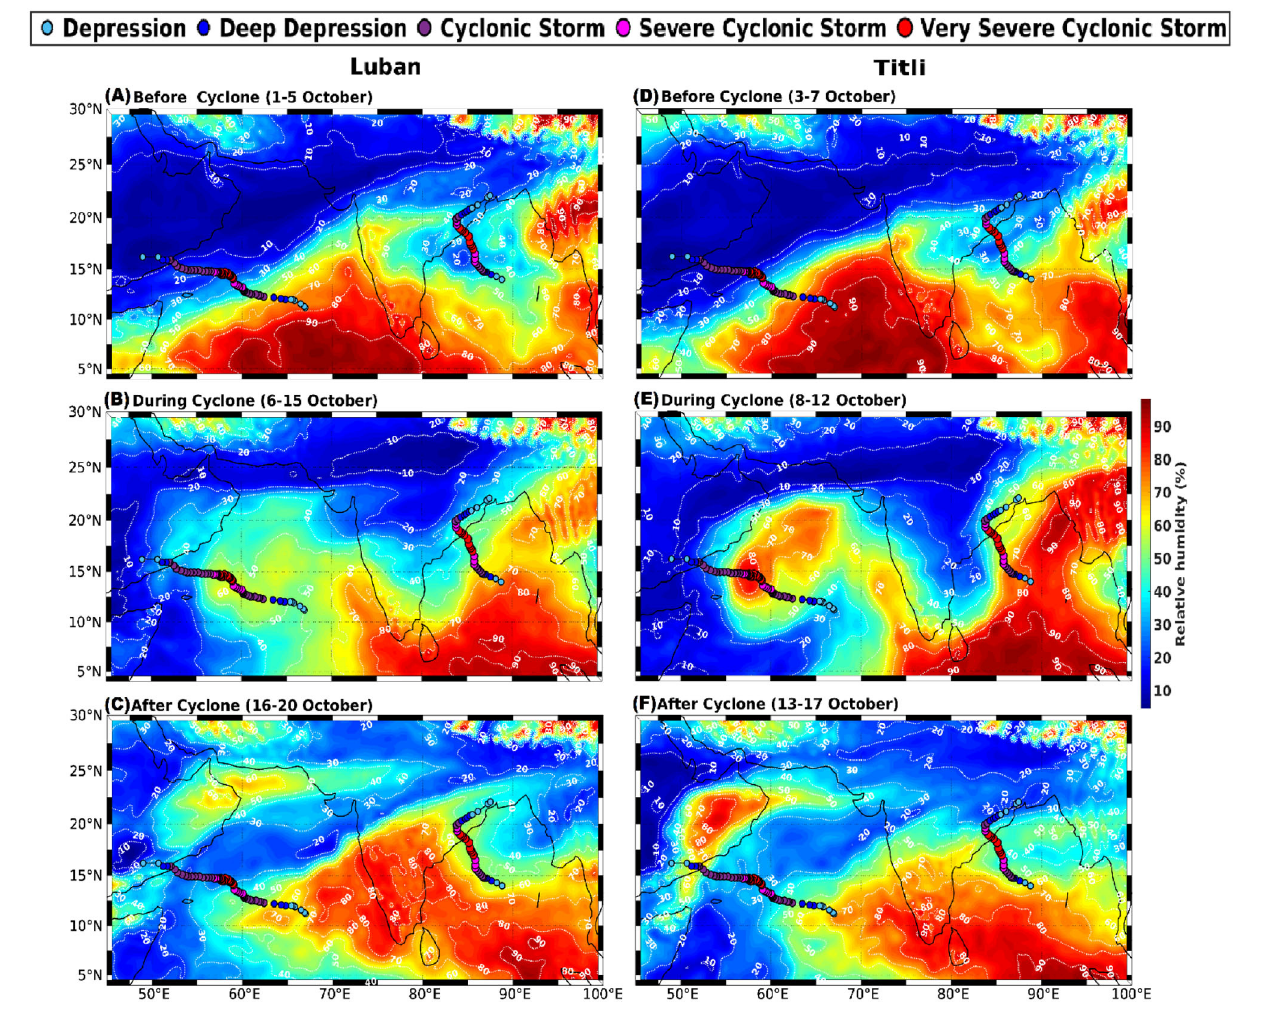
FIGURE 11 | A spatial map of mid-tropospheric (500 hPa) relative humidity (%) before (A,D) , during (B,E) , and after (C,F) cyclones Luban (A–C) and Titli (D–F) . The color-filled circles denote the